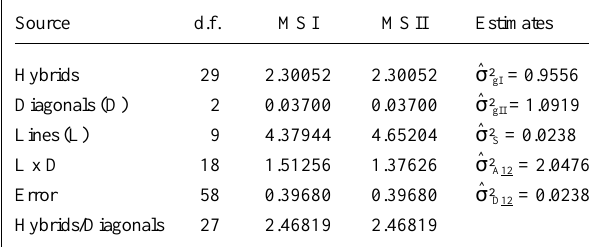
Table VIII - Analysis of variance with partition of the total sum of squares according to the factorial model. Ear length of 30 corn